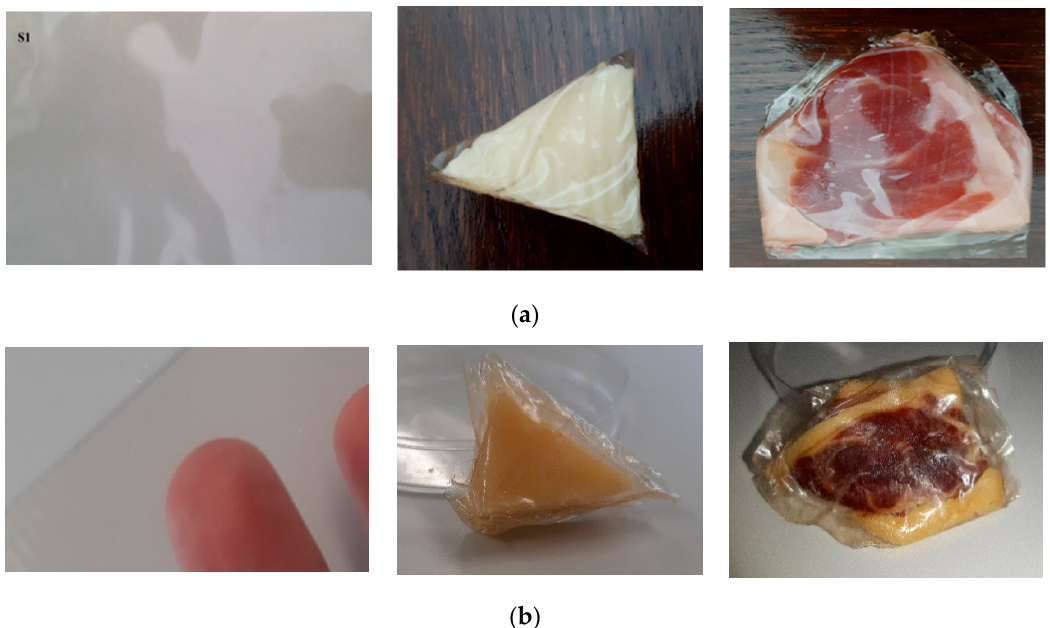
Figure 3. The film and the products packed at the initial moment ( a ) and after 5 months of maintenance in refrigeration conditions ( b ).